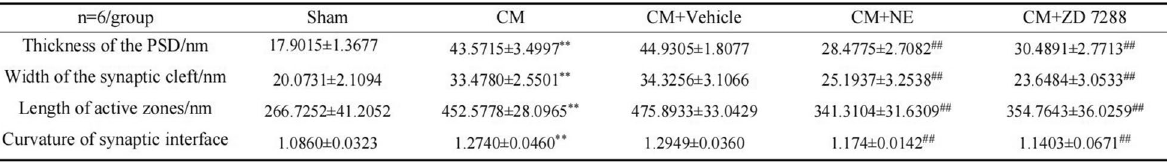
Table 3 Synaptic ultrastructure parameters in the PAG neurons in each group